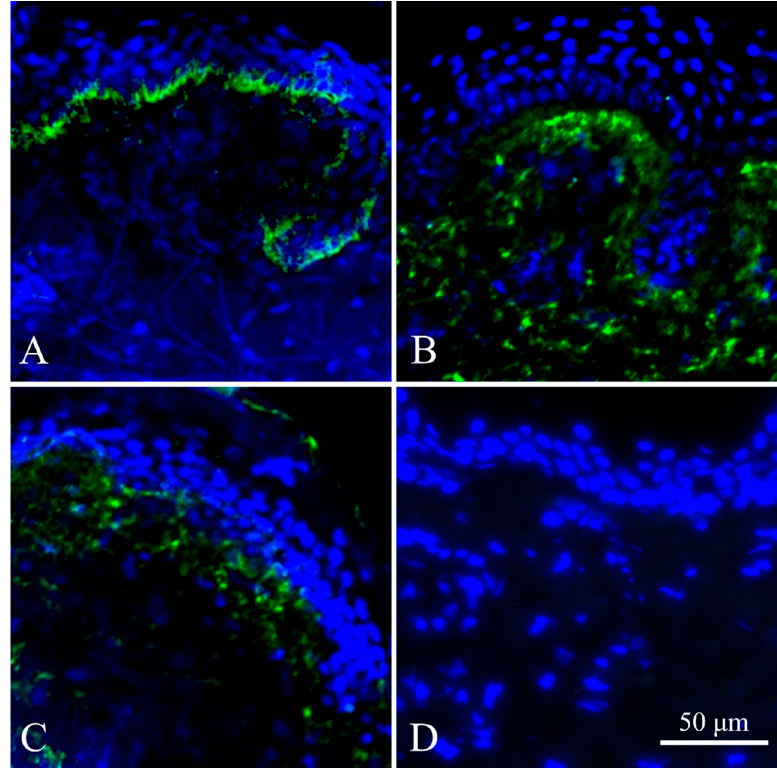
Figure 2. Immunohystochemistry IHC staining of skin cryosections. ( A ) Skin of healthy donor d6. ( B ) Skin of patient d2 with RDEB inversa. ( C ) Skin of patient d3 with generalized severe RDEB. ( D ) Autoimmunofluorescence of skin. Green channel—type VII collagen. Blue channel—DNA (DAPI). Fluorescent microscopy.